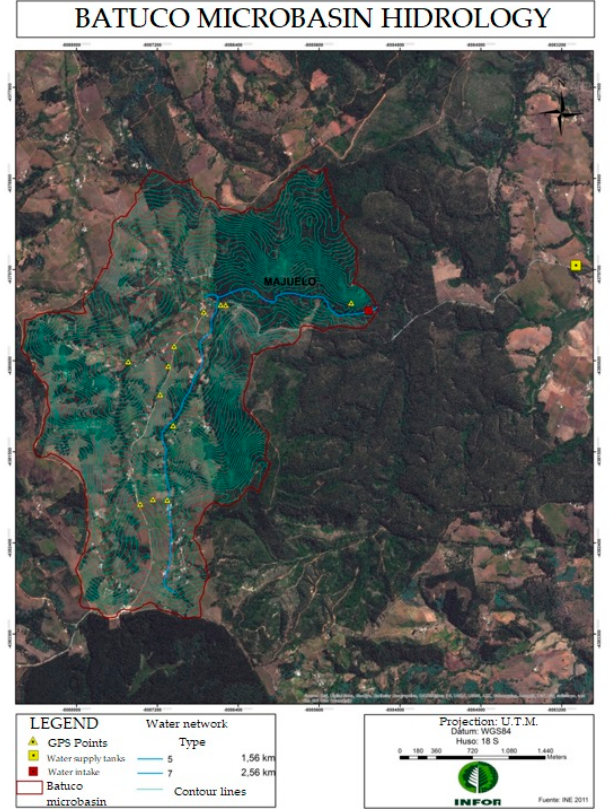
Figure 2. Water supply system (light blue), water intake area (red dot), and supply pumps (yellow square) of Batuco Water Committee, Global Positioning System (GPS) points (yellow triangle). Source: Compiled by authors from www.bosquesyagua.cl and field study.